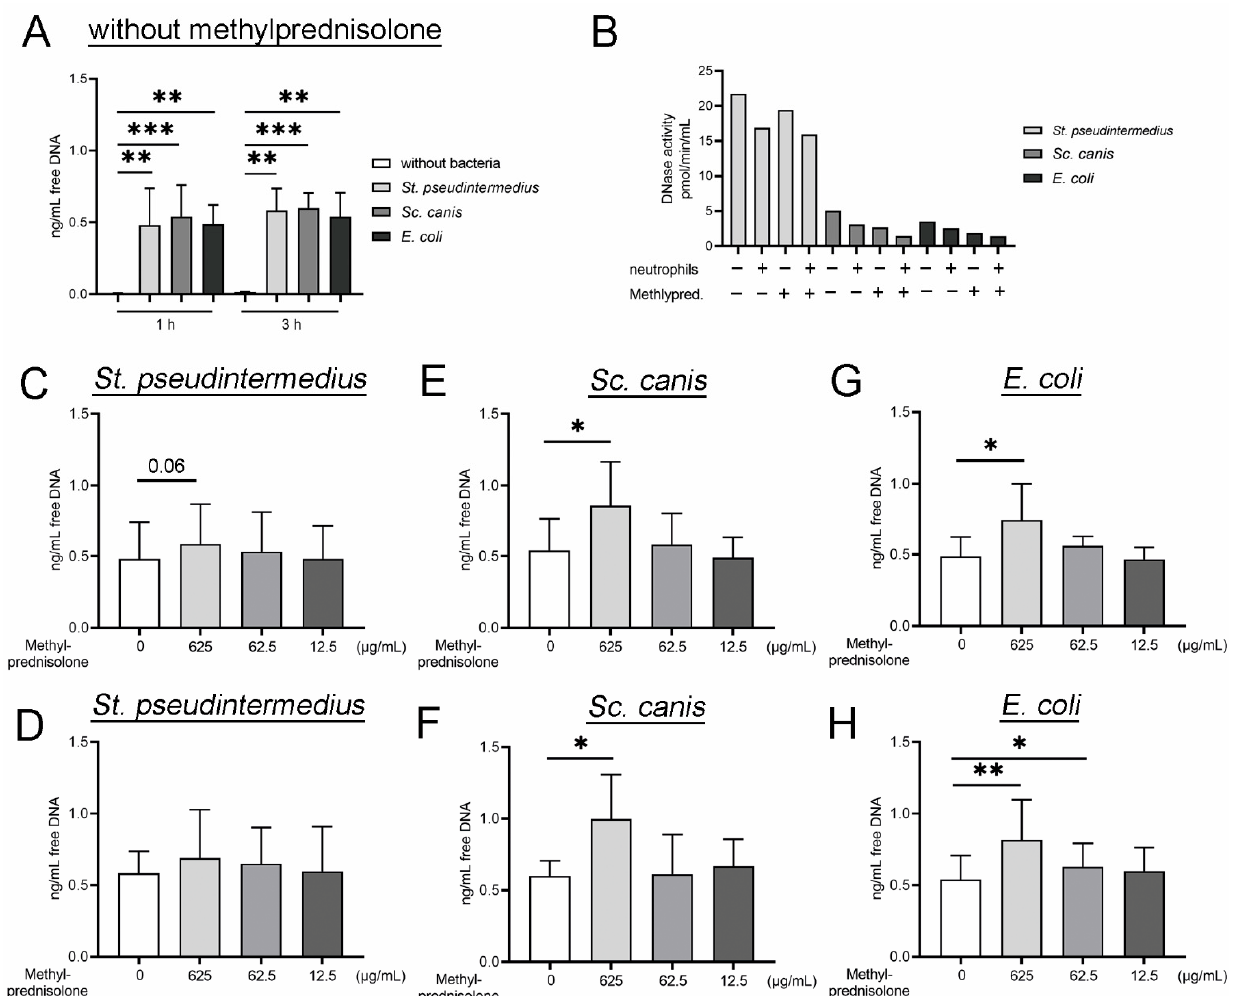
Figure 2. Free DNA is released by neutrophils after bacterial infection. The amount increased significantly in the presence of low DNase activity and methylprednisolone co-stimulation. The supernatants from bacterial killing assays from Figure 1 were analyzed for free DNA and partially for DNase activity. ( A ) Neutrophils incubated without methylprednisolone release free DNA into the supernatant after incubation with bacteria. Sc. canis induced the highest release of free DNA. ( B ) The DNase activity was determined in a selected sample collection ( n = 1, 3 h post infection), including additional controls without neutrophils. Same tendencies in DNase activity were detected in all three bacterial strains. The highest DNase activity was detected in samples with St. pseudintermedius . In the presence of neutrophils, the DNase activity is slightly reduced. Furthermore, in the presence of 625 µ g/mL methylprednisolone, the DNase activity is always reduced. ( C , D ) A notable higher amount of free DNA was detected only after 1 h of co-incubation from neutrophils with St. pseudintermedius and 625 µ g/mL methylprednisolone. ( E , F ) A significant higher amount of free DNA was measured one and three hours after co-incubation of neutrophils with Sc. canis and 625 µ g/mL methylprednisolone. ( E , F ) A significantly higher amount of free DNA was measured one and three hours after co-incubation of neutrophils with E. coli and 625 µ g/mL and 62.5 µ g/mL methylprednisolone, respectively. All graphs show the mean ± SD and statistical differences were detected by one-tailed paired Student’s t -test. The experiments were conducted in independent runs (1 h: n = 4; 3 h: n = 5). Data presented in A are shown partially again in ( C – H ) for statistical analysis in the different infection groups. Statistical results are presented for values lower than 0.1 and higher than 0.05 as Arabic numbers and as the following: *, p < 0.05; **, p < 0.01; ***, p <